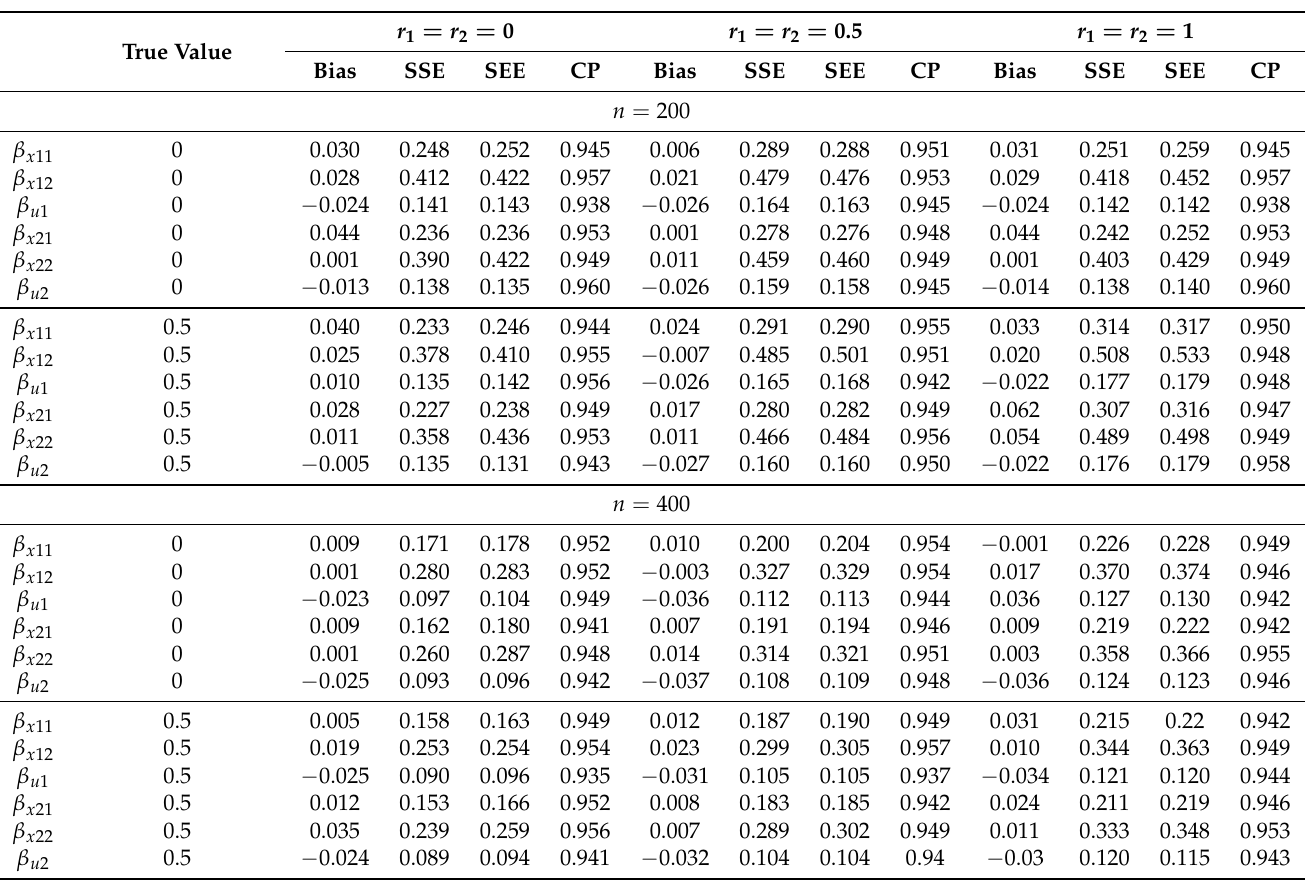
Table 1. Simulation results on estimation of β with the b i ’s generated from the normal